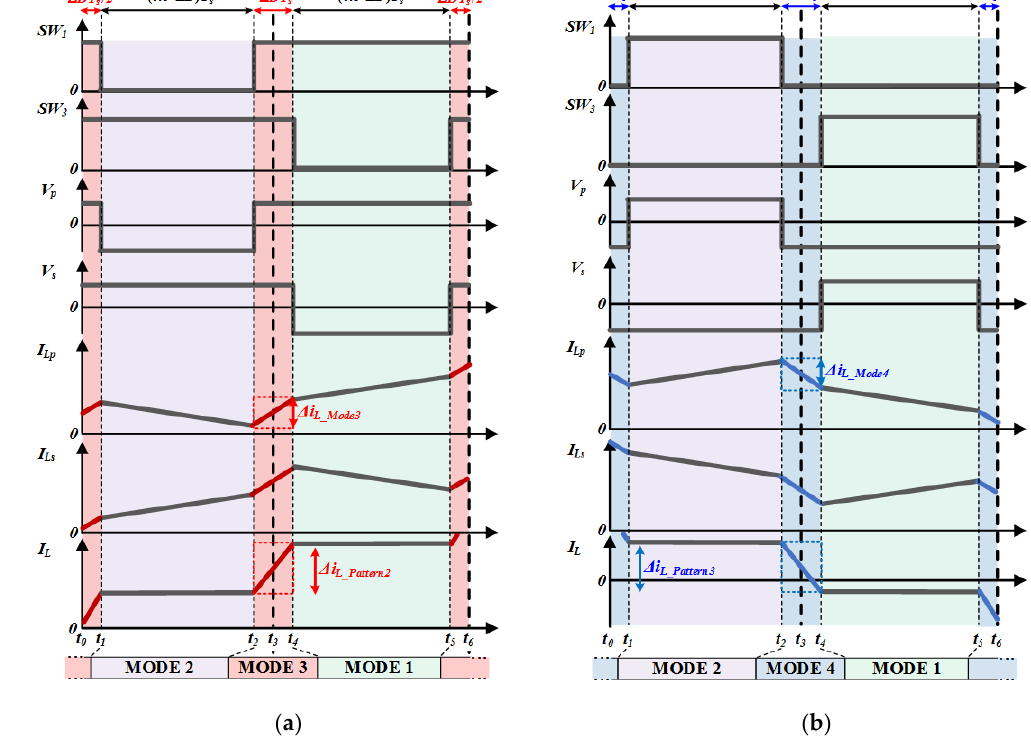
Figure 6. Switching scheme of proposed VB under loads condition: ( a ) Pattern 2: Unbalanced load (increased loads of negative voltage pole); ( b ) pattern 3: Unbalanced load (decreased loads of negative voltage pole).